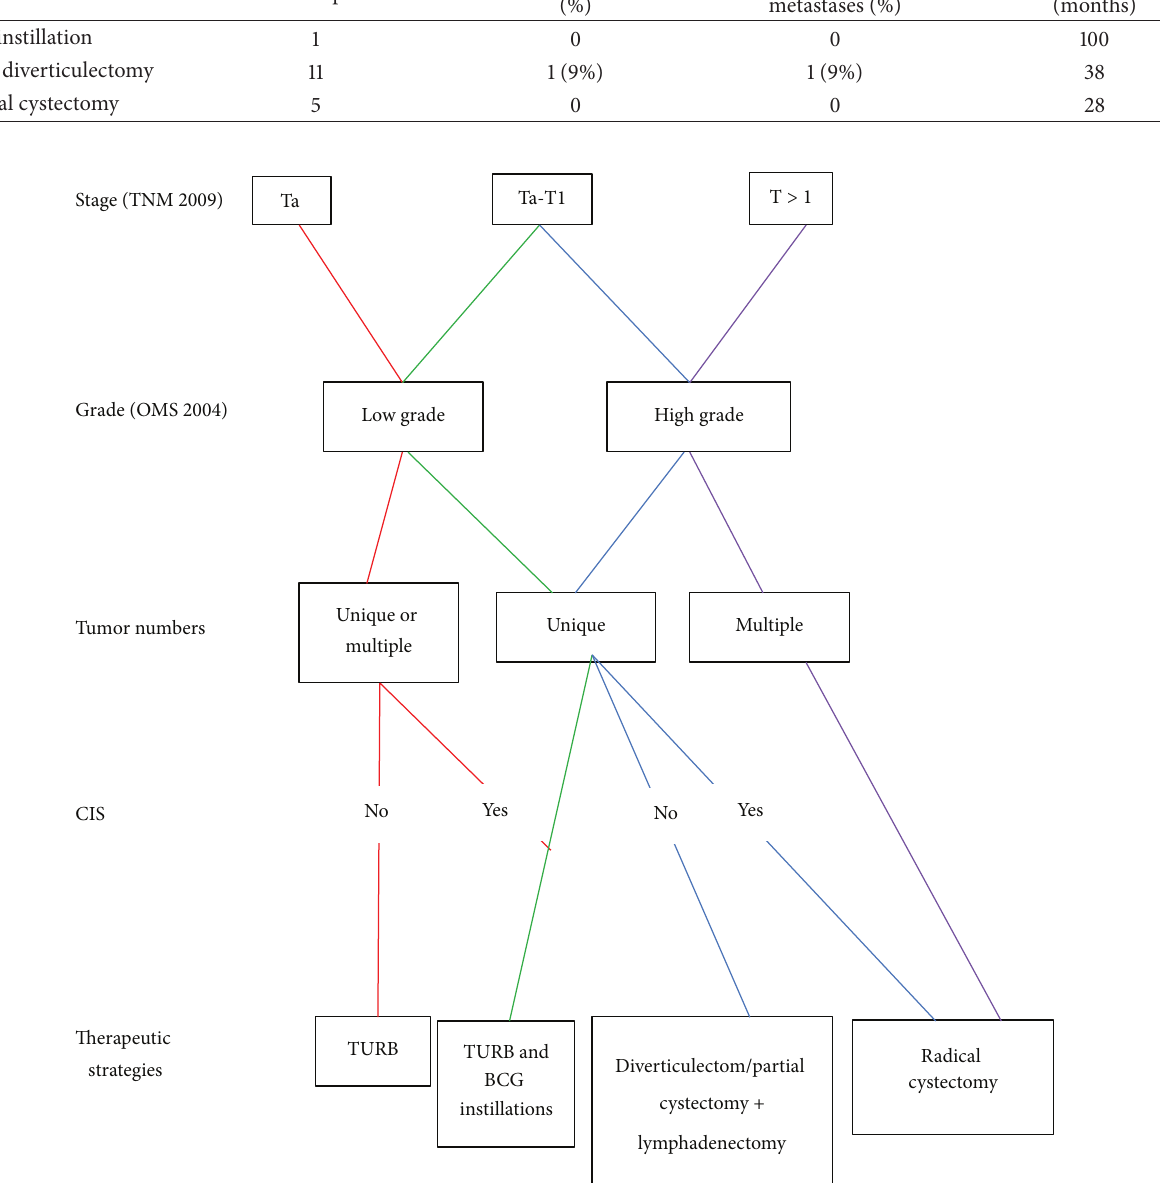
Figure 1: Management of intradiverticular bladder tumor: review of the cancer committee of the French Association of Urology.